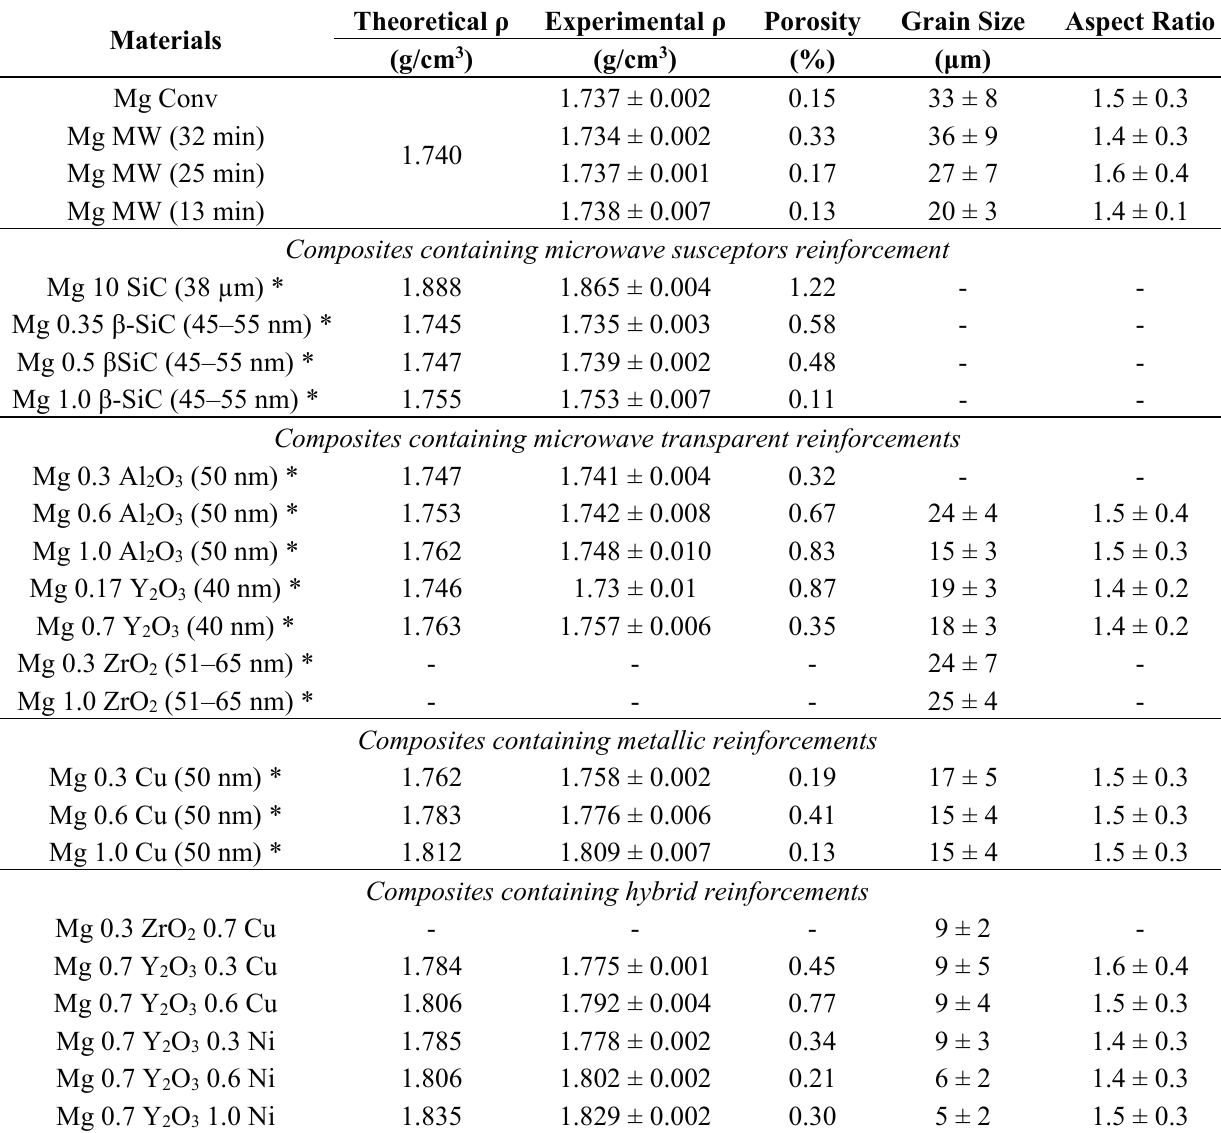
Table 3. Results of density and porosity